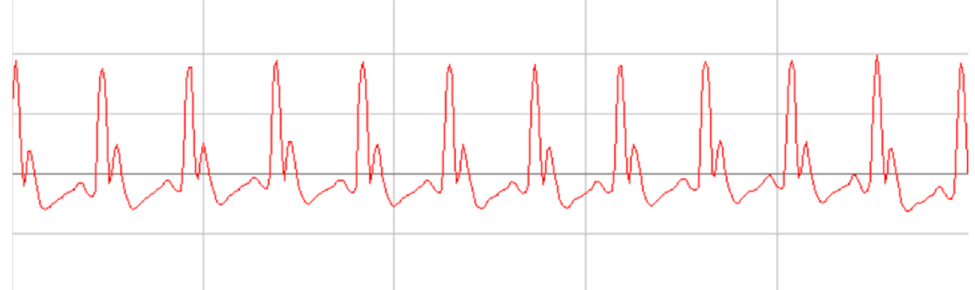
Figure 3. Normal EGC record from first day of experiment. The second ECG evaluation performed on day 14 before ISO administration did not find significant differences between animals that received NSO or GSO for 2 weeks, along with no significant variation compared to basal records ( p > 0.005). Heart rate was significantly increased by ISO in all experimental groups compared to baseline records ( p < 0.001) (Table 6). ISO administration increased heart rate compared to the control group ( p < 0.001). Pretreatment with GSO prevented the increase in heart rate induced by ISO ( p ≤ 0.036), but this was not the case for NSO ( p = 0.267). Table 6. ECG parameters recorded after MI (day 14). C (control group), C-ISO (ISO group), NSO + ISO ( Nigella sativa seed oil and ISO group), GSO + ISO (grape seed oil and ISO group), HR (heart rate).